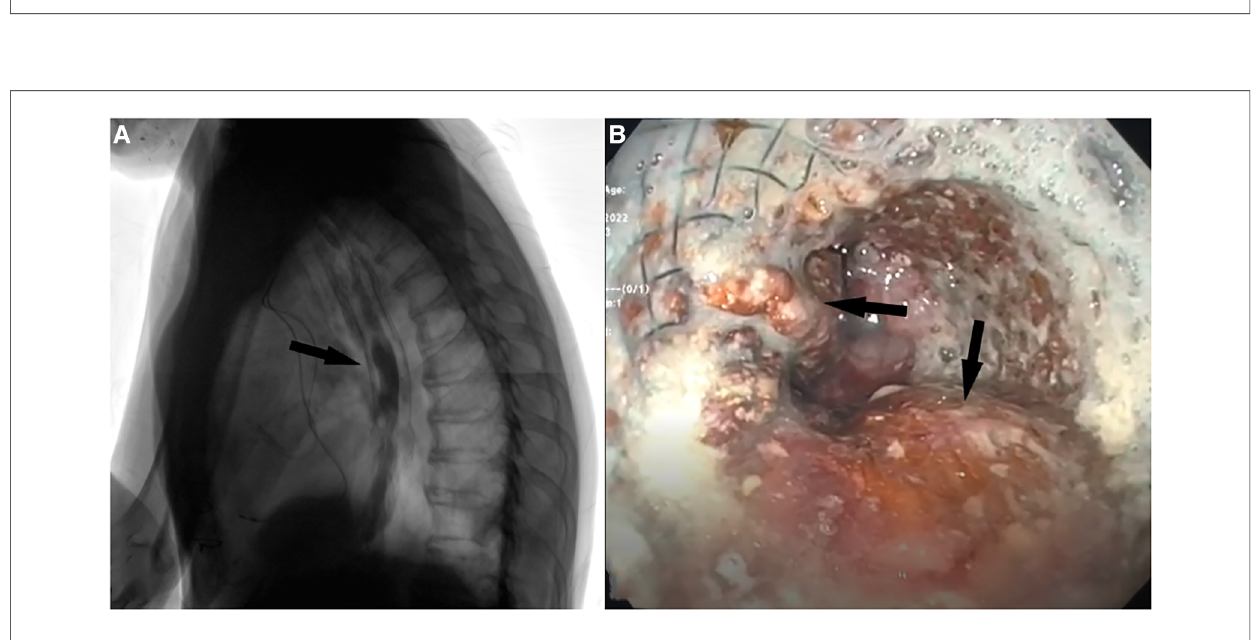
FIGURE 2 Intraoperative bronchoscopic procedure. ( A ) Rigid bronchoscopy showing TEF with esophageal stent protruding inside tracheal lumen in two different sites (red arrows); ( B ) TEF margins freshened using aspirator; ( C ) positioning of fascia lata (red arrow) over TEF with forceps; ( D ) tracheal stent correctly positioned over fascia lata